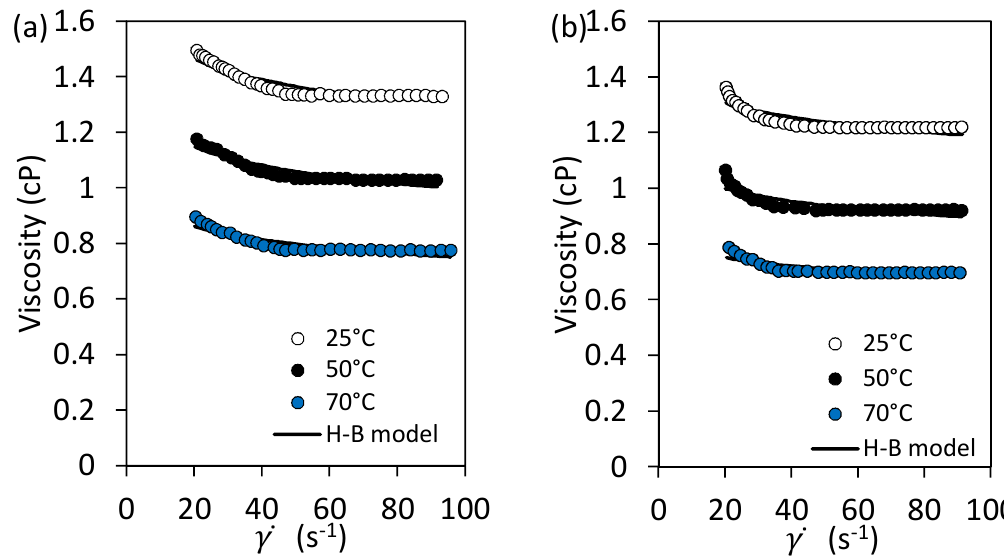
Figure 9. Rheological behavior of nanofluids containing 10 mg/L of ( a ) NCS20 and ( b ) NCP50 materials in deionized water at 25, 50, and 70 °C. Table 1. Parameters of the Herschell-Bulkley rheological model at 25, 50, and 70 °C for the nanofluids containing 10 mg/L of NCS20 and NCP50.